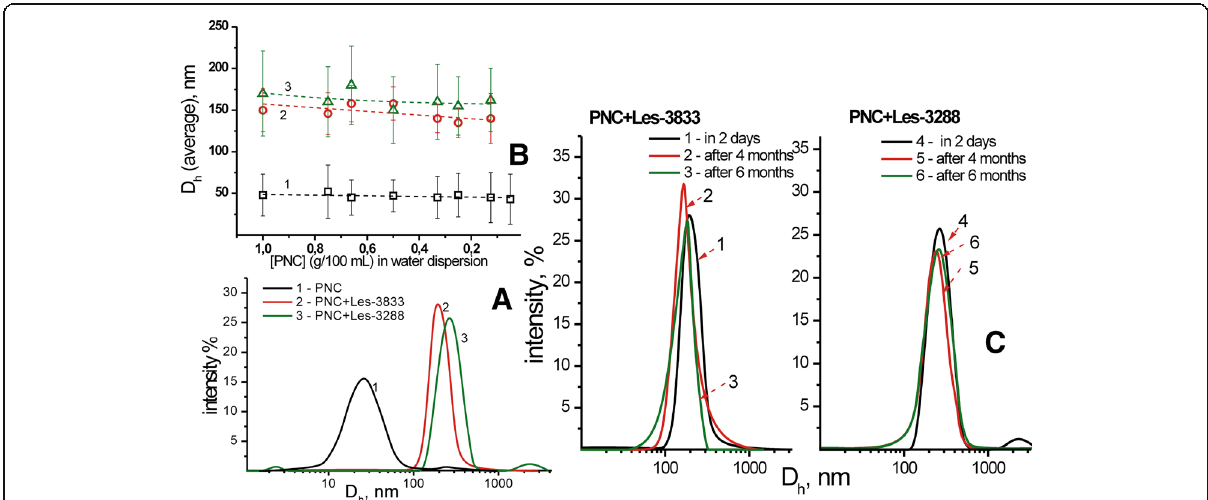
Fig. 4 DLS study of hydrodynamic diameters of PNC and complexes ( a ) and dependence of average sizes of PNC-drug complexes on dispersion dilution ( b ): water dispersions of PNC (1), complexes of Les-3833+PNC (2), and Les-3288+PNC (3), as well as hydrodynamic sizes of Les-3833+PNC (1 – 3) and Les-3288+PNC (4 – 6) dispersions after storage for 2 days (1.4), 4 months (2.5), and 6 months (3.6) ( c